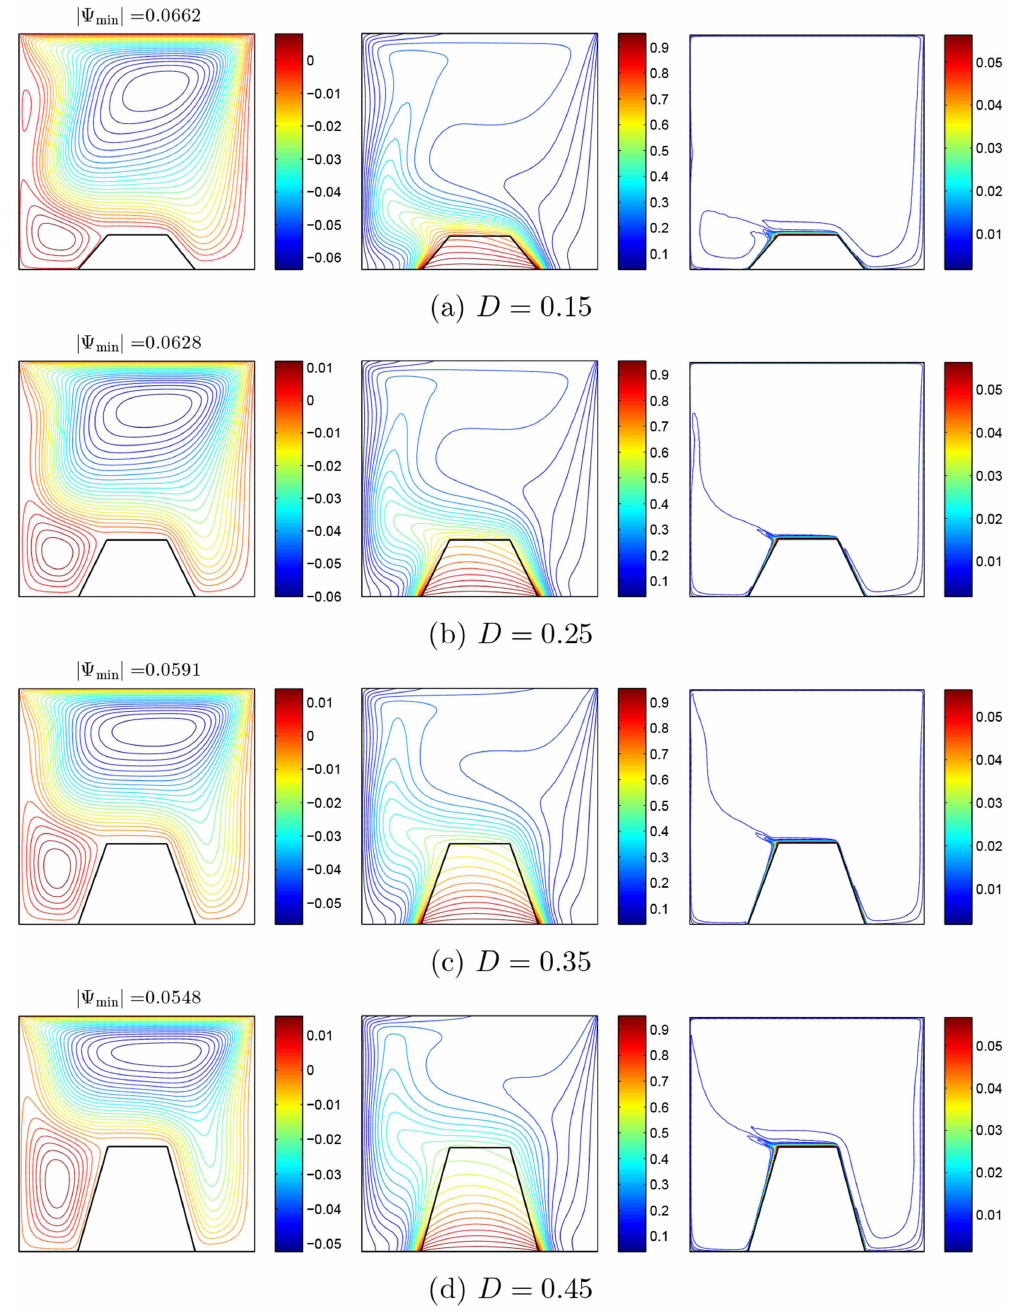
Figure 9. Effects of the trapezoidal body ( D ) on the streamlines (left), isotherms (middle), and nanoparticle distribution (right) for Ri = 10, Ha = 20, and φ =